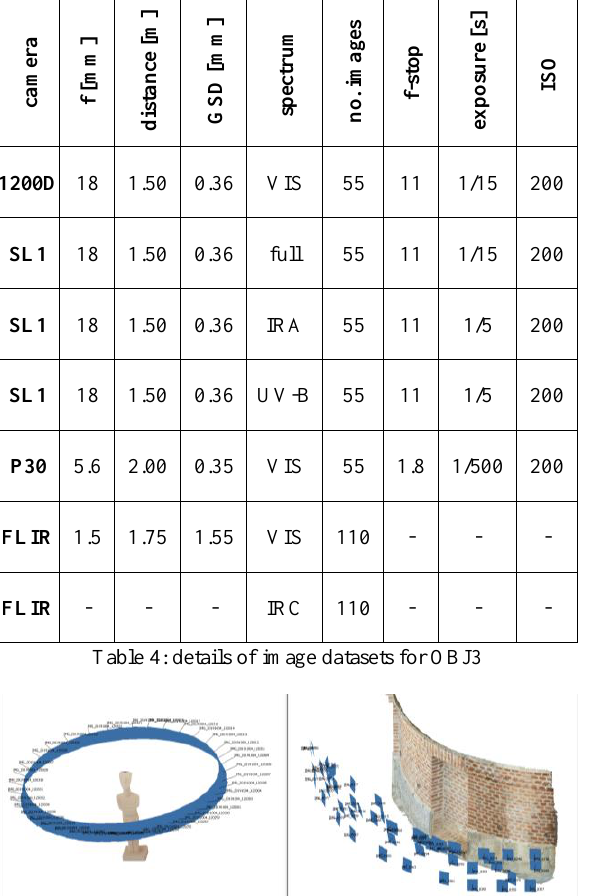
Figure 1: data acquisition scenarios OBJ1(left) and OBJ3(right)